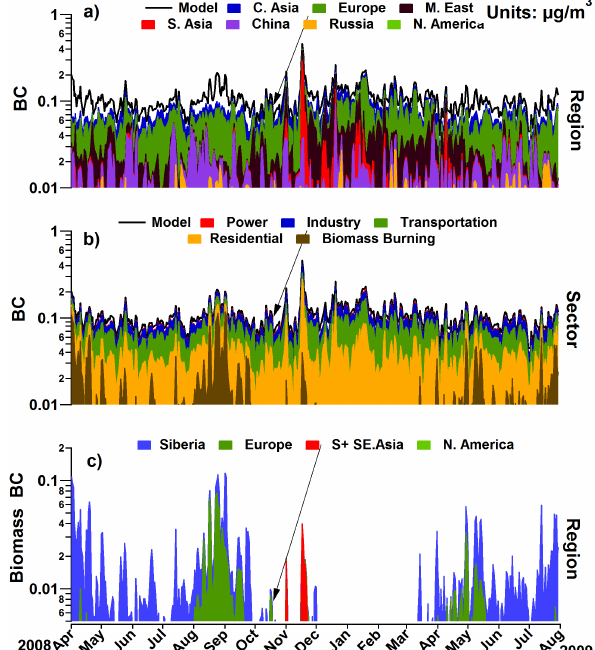
Figure 12. Simulated composition of BC at the LST site by (a) source regions (µgm − 3 ) , (b) source sector (µgm − 3 ) , and (c) biomass burning source regions (µgm − 3 )